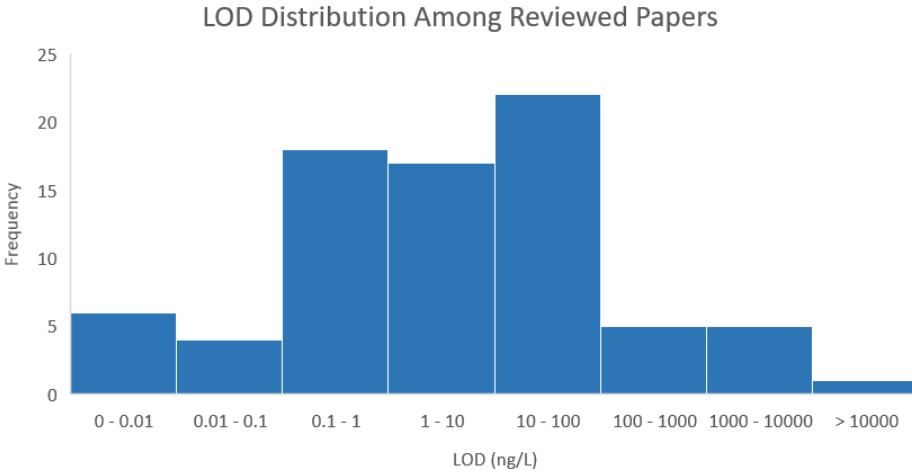
Figure 4. LOD of reviewed papers. Data for the 77 reviewed papers was collected and the assays and biosensors are arranged into subsets based on the LOD. The qualitative colourimetric technique was excluded [37,38,48–50,57,58,61,65,66,68–71,74,84–89,93–97,104,105,111,112,115–117,120–123,125–128,130,132– 134,136,138,144,145,148,150,151,159,161,174–176,184–202] .